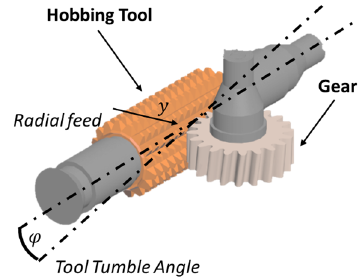
Figure 2. Sensor integration in the machine (image source: [26].)